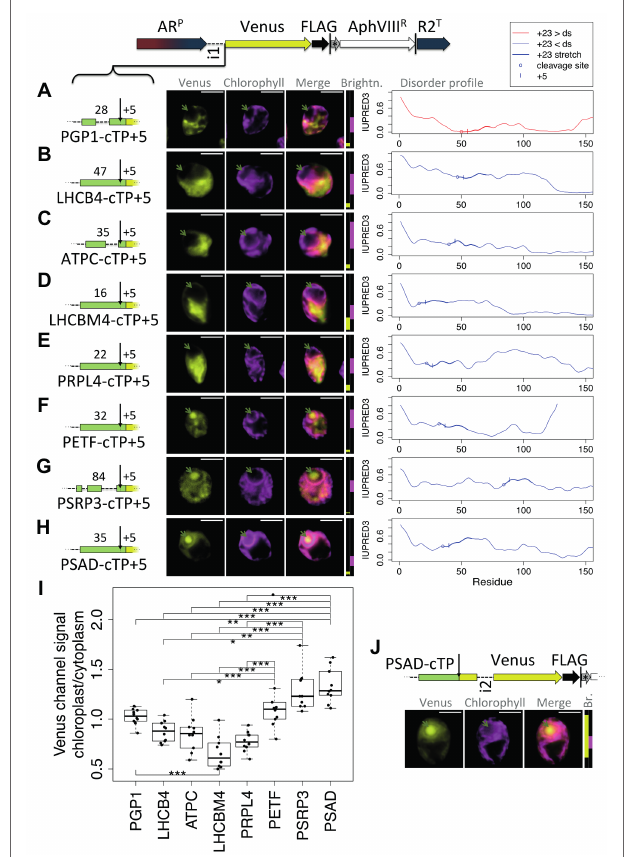
FIGURE 6 | Efficient chloroplast import relies on post-cleavage site sequence in many cTPs. Candidate chloroplast targeting peptides, each including 5 post-cleavage site residues, from (A) phosphoglycolate phosphatase (PGP1), (B) chlorophyll a/b binding protein of photosystem II, also known as CP29 (LHCB4), (C) chloroplast ATP-synthase gamma chain (ATPC), (D) chlorophyll a/b binding protein of light harvesting complex II (LHCBM4), (E) plastid ribosomal protein L4 (PRPL4), (F) chloroplast ferredoxin (PETF), (G) plastid-specific ribosomal protein 3 (PSRP3), and (H) Photosystem 1 subunit D (PSAD), were inserted upstream of Venus. Individual IUPRED3 disorder profiles are shown as in Figure 4B , with the +23 stretch highlighted and the +5 residue marked by |. (I) Epifluorescence images were quantified by measuring mean Venus channel signal inside and outside the chloroplast. Statistical significance is indicated as: * p < 0.05, ** p < 0.01, and *** p < 0.001; Tukey’s honestly significant difference post-hoc test, after ANOVA. (J) A second PSAD construct lacking post-cleavage site residues was probed. Lengths in amino acid residues are indicated above each peptide; green arrows show pyrenoid location; see Figure 1 for further details on